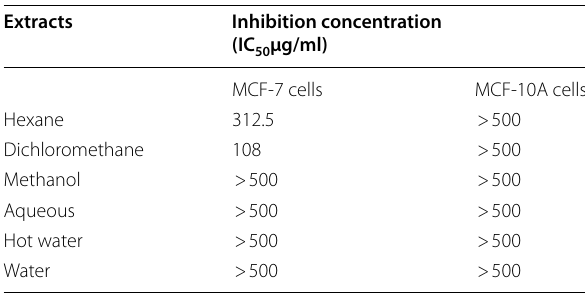
The half-maximal inhibition concentration (IC 50 ) of antiproliferative activity at various concentrations of 72-h treatment. All values are presented as mean